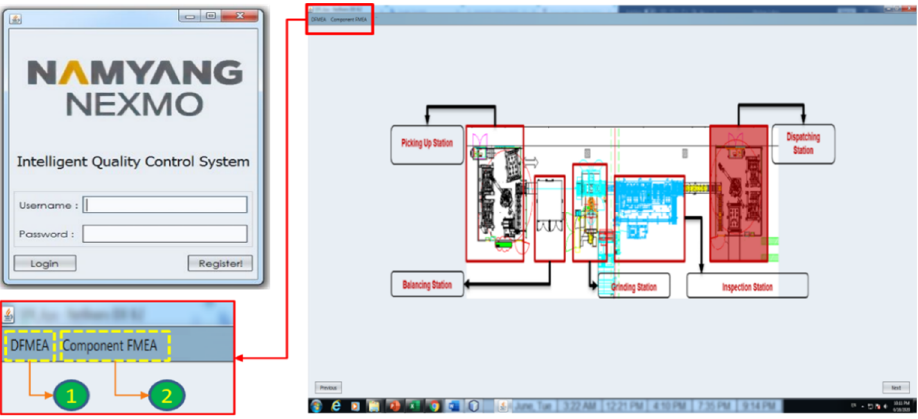
Figure 7. User interface and main interface of the system.